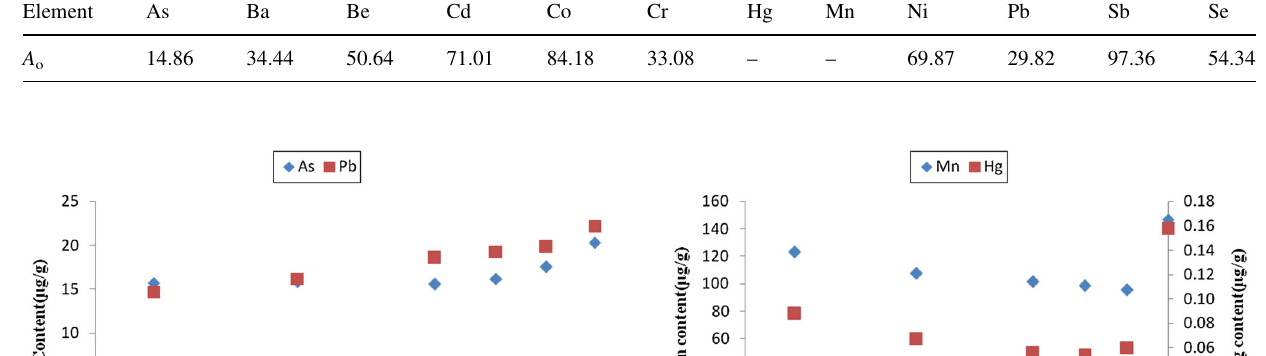
Table 8 Organic affinity of the trace elements in No.14 coal from Huolinhe mine Element As